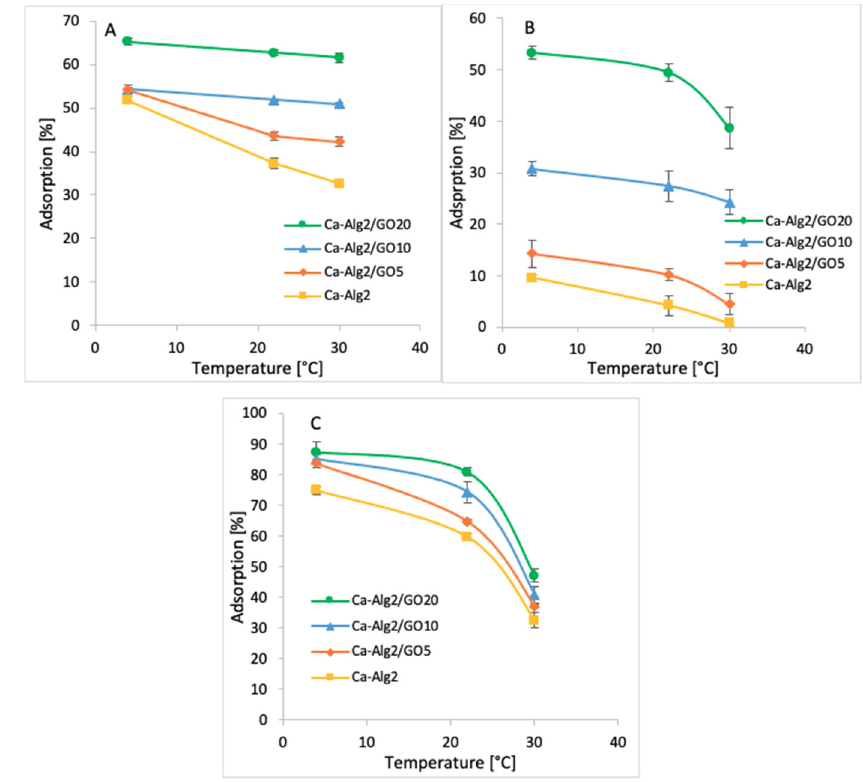
Figure 11. Effect of the temperature on q eq of MB ( A ), FMTD ( B ), DFC ( C ).